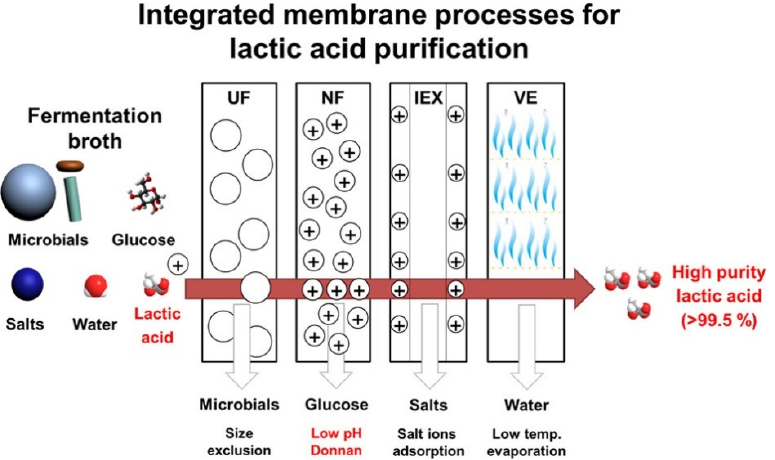
Figure 9. Integrated membrane processes for lactic acid purification. Reprinted with permission from [227]. Copyright 2017 American Chemical Society.